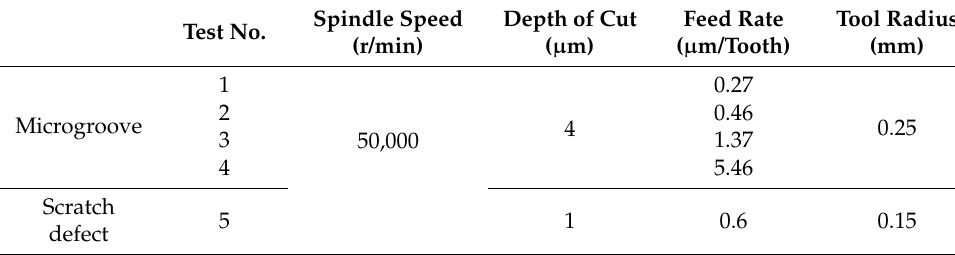
Table 5. Cutting parameters applied in the micro-milling repair process of KDP crystals. Test